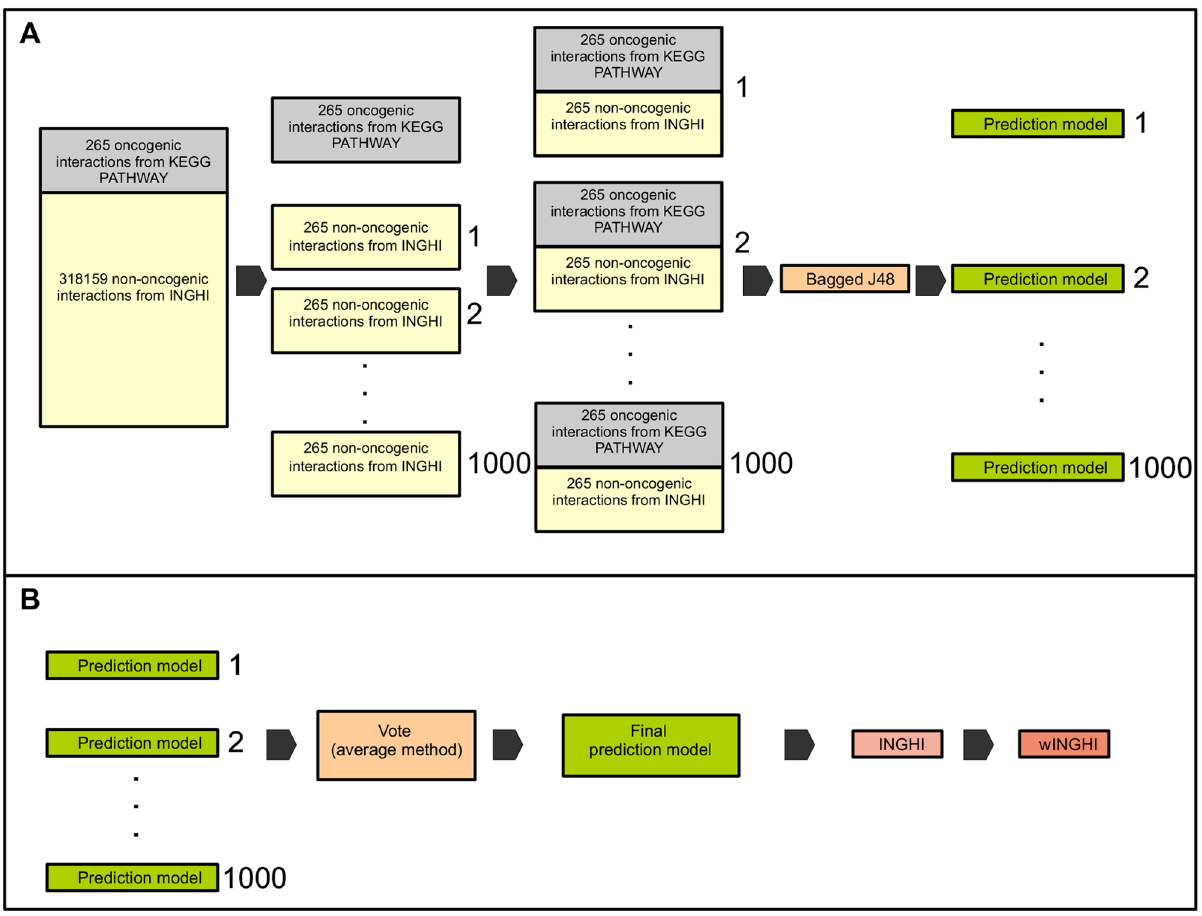
Figure 1. Initial steps of graph2sig . After building the INHGI and calculating the network centralities, balanced training groups are constructed and presented to the selected machine learning algorithm (bagged J48) that, in turn, generates the prediction models as depicted in (A) . These prediction models are combined in one final prediction model by the Vote algorithm. This final model is then used to assign oncogenic scores to interactions in INHGI originating the wINHGI as shown in (B) .